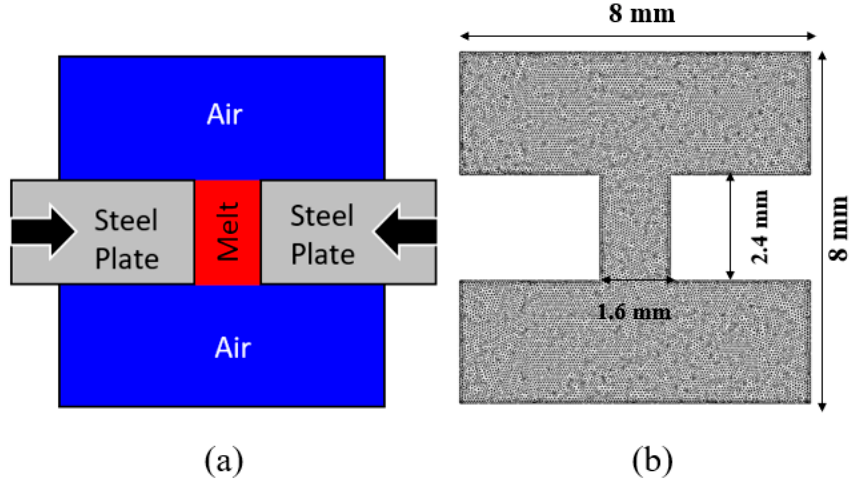
Figure 2. ( a ) Schematic of domain, ( b ) domain meshing.